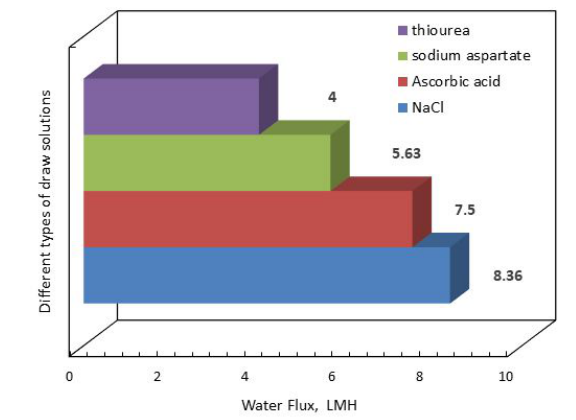
Fig. 3. Average water flux of various draw solutions (FS: distilled water, T = 25 0 C, conc: 1M ascorbic acid, 1M sodium L-aspratate, 1M thiourea and 3.5% NaCl, FO mode).